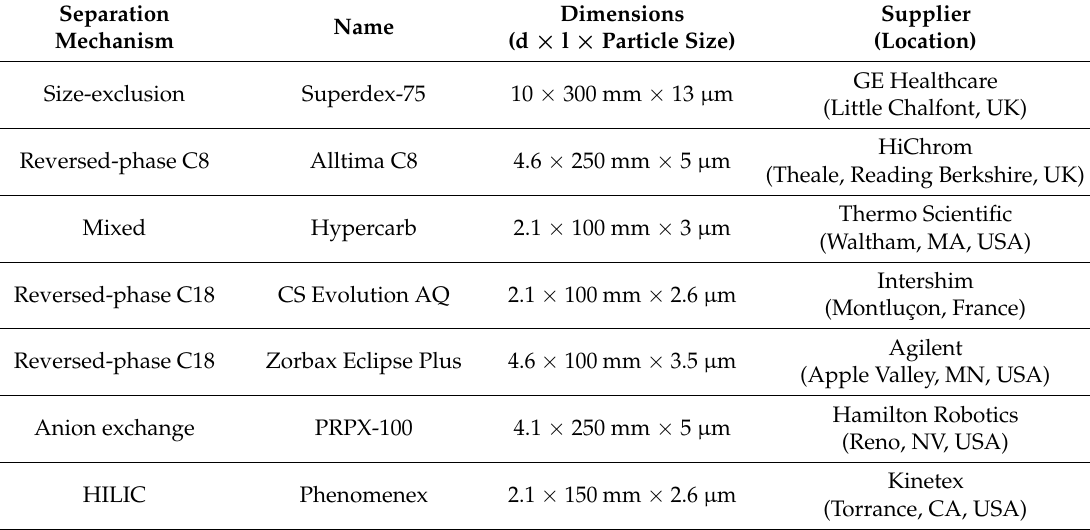
Table 4. Chromatographic columns